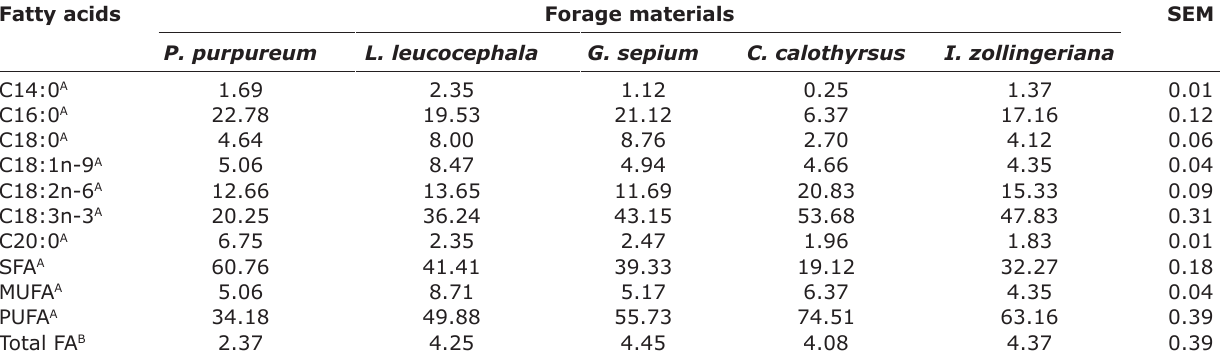
Table-2: Fatty acid composition of forage materials for in vitro fermentation. Fatty acids Forage materials